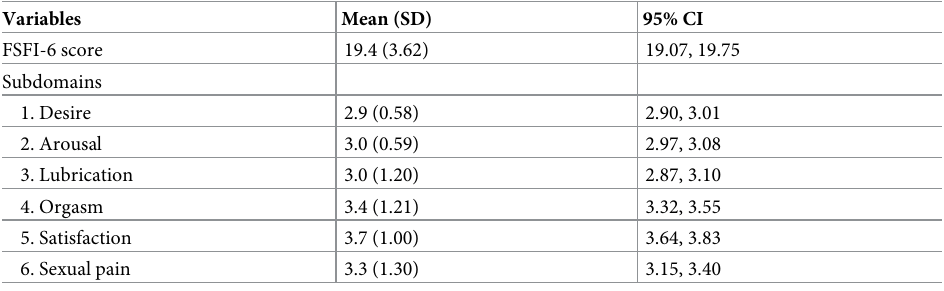
Table 2. Female sexual dysfunction and subdomain